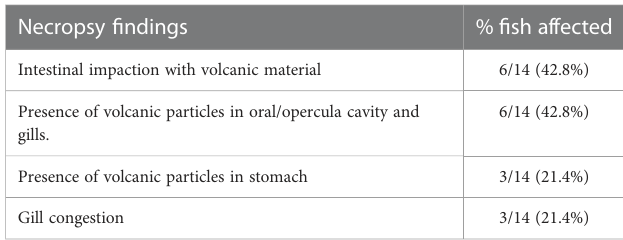
TABLE 2 Necropsy fi ndings reportedindead fi shes from LaPalmavolcano eruption. Necropsy fi ndings % fi sh affected Intestinal impaction with volcanic material 6/14 (42.8%) Presence of volcanic particles in oral/opercula cavity and